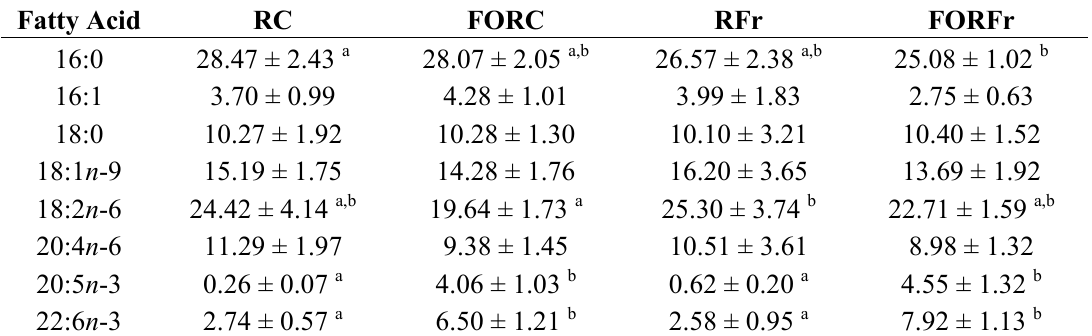
Data are means as mol percent of the total fatty acid methyl esters. Values across a row marked with the same letter are not significantly different ( p < 0.05) by Tukey’s test ( a,b ). RC—refed control group; FORC—fish